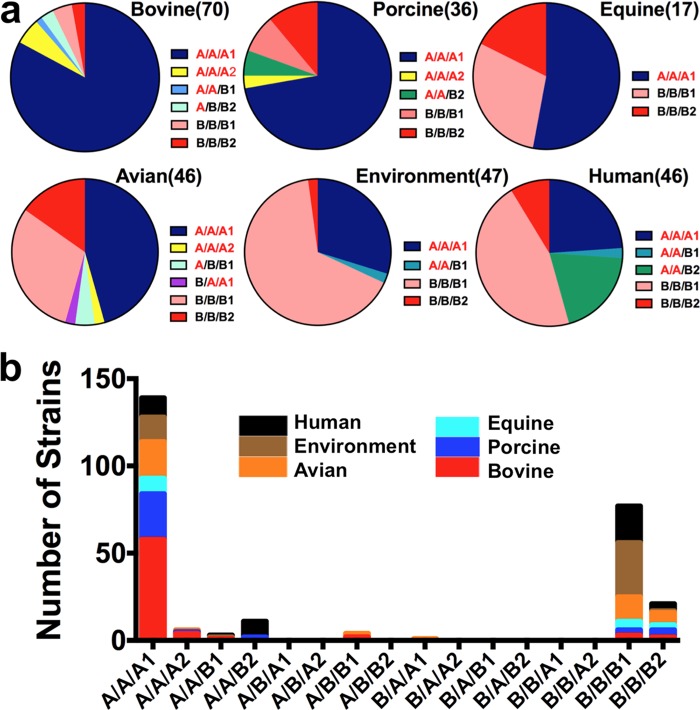
Combinations of adhesin alleles for each isolation source. (a) Relative frequencies of S. Newport strains, with each detected combination of adhesin alleles grouped by isolation source. The detected allele combinations of FimH/BcfD/StfH for each source are listed on the right of the corresponding pie charts. The following colors were used for the different combinations: dark blue (A/A/A1), medium blue (A/A/B1), light blue (A/B/B1), green (A/A/B2), pink (B/B/B1), red (B/B/B2), and purple (B/A/A1). Six strains with an StfH group A2 allele (four bovine strains, one porcine strain, and one avian strain) were excluded from the charts. (b) Numbers of each combination of alleles are shown with stacked columns, with each color representing the corresponding number for one source of isolates (human, black; environment, brown; avian, orange; equine, light blue; porcine, blue; bovine, red).